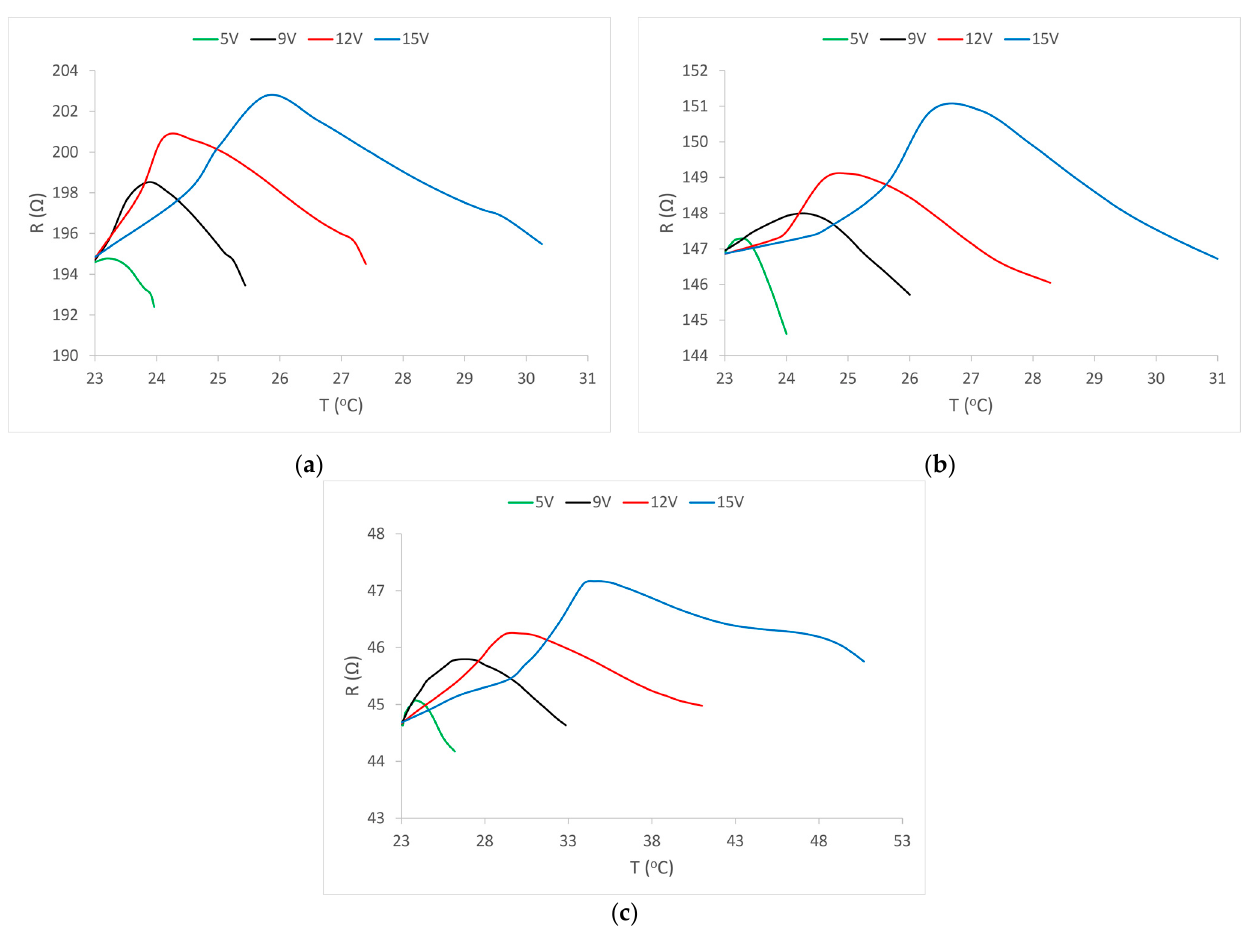
Figure 7. Change in the electrical resistance of the electrically conductive yarn with increasing temperatures at certain voltage values: ( a ) sample 1; ( b ) sample 2; ( c ) sample 3. In the continuation of the presentation of the results, diagrams of the change in resistance depending on the increase in the temperature of the conductive yarn are given.